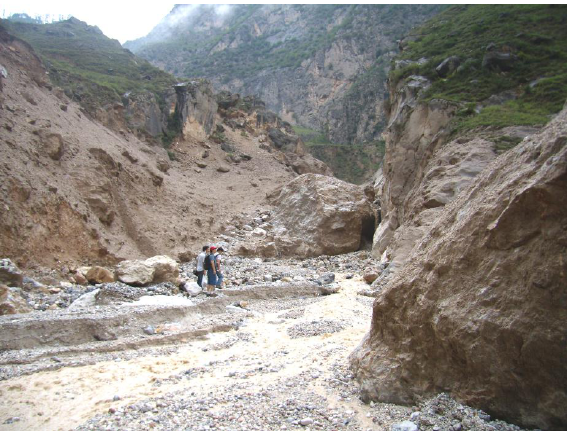
Fig. 9. Main flow track of the Sanyangyu torrent. The channel banks were scoured and widened after debris flow moved downs- Fig. 9 Main flow track of the Sanyangyu torrent. The channel banks were scoured and 3 widened after debris flow moved downslope. 4